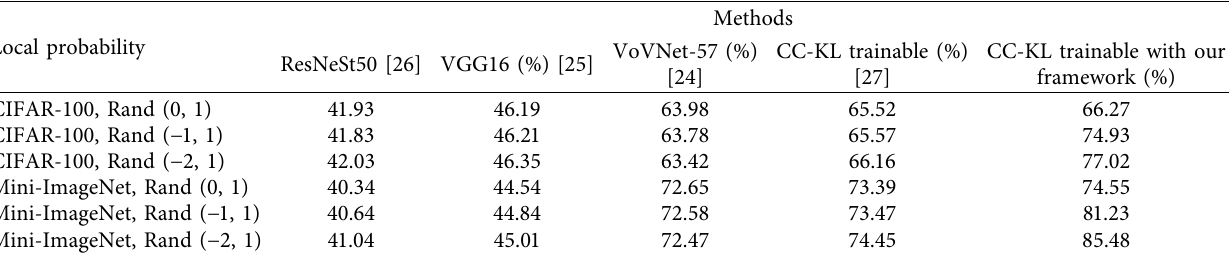
Table 6: The result of random probability on CIFAR-100 and Mini-ImageNet with fusion operators. Local probability